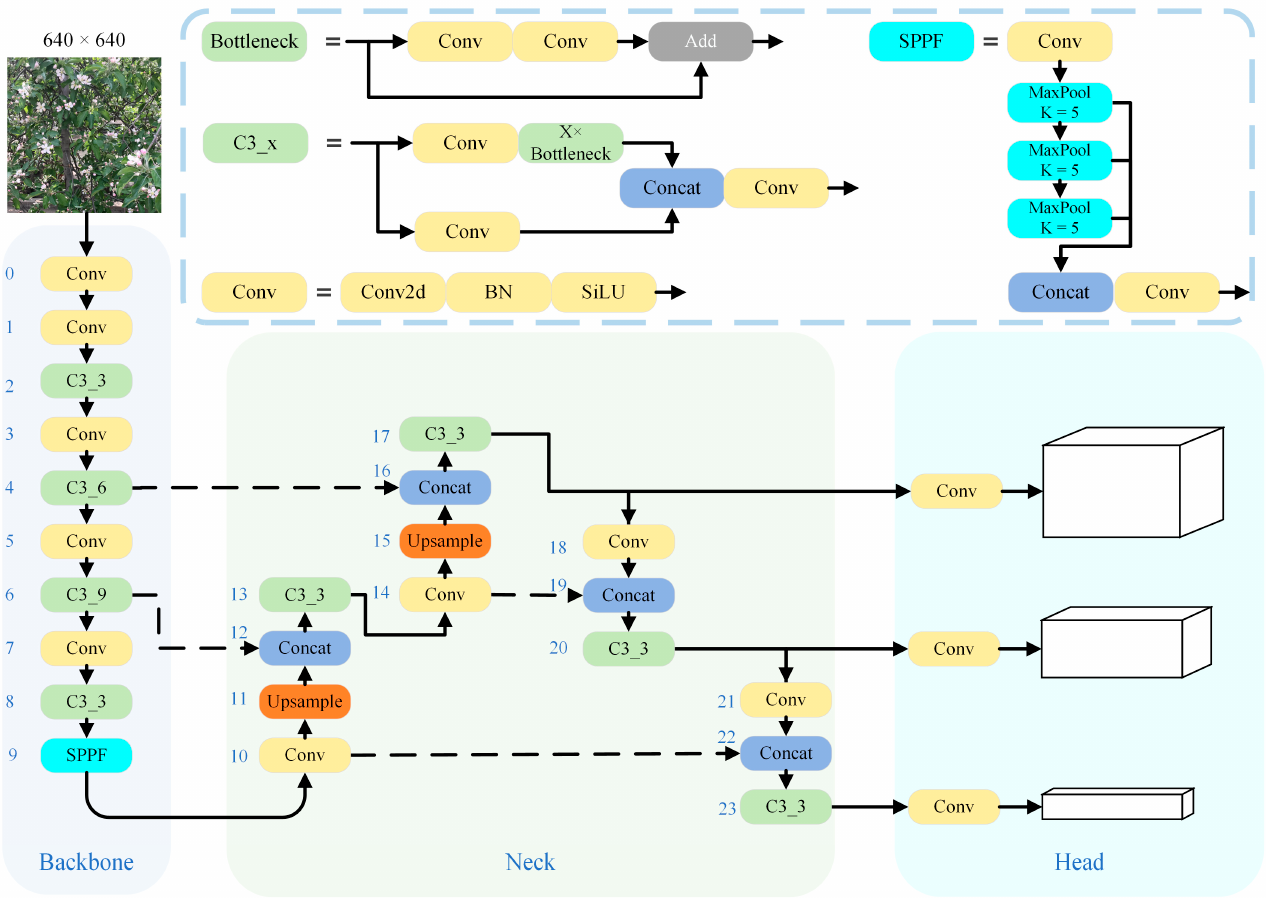
Figure 6. YOLOv5 model. The number to the left of each layer of the network is used to mark the number of the